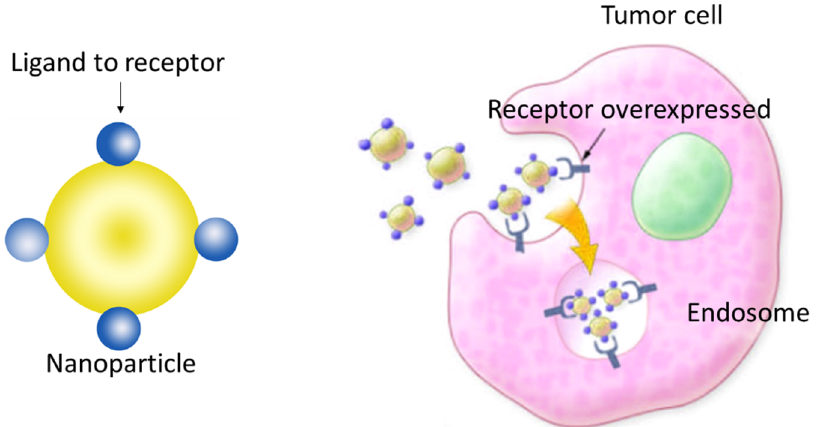
Figure 2. After disrupting the blood-brain barrier (BBB), nanoparticles (NPs) can accumulate at the tumor site. Receptor-mediated endocytosis of the functionalized NPs by cells overexpressing a receptor can retain NPs inside the